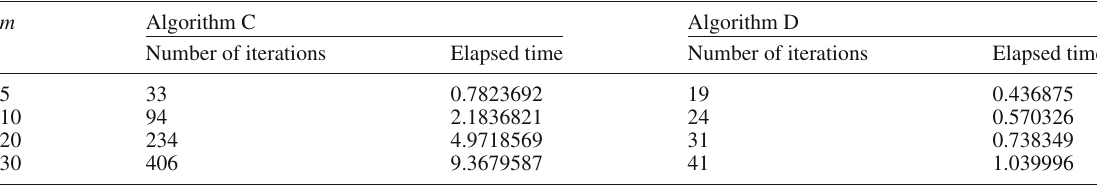
Table 2 Numerical values for Figs. 1, 2, 3 and 4